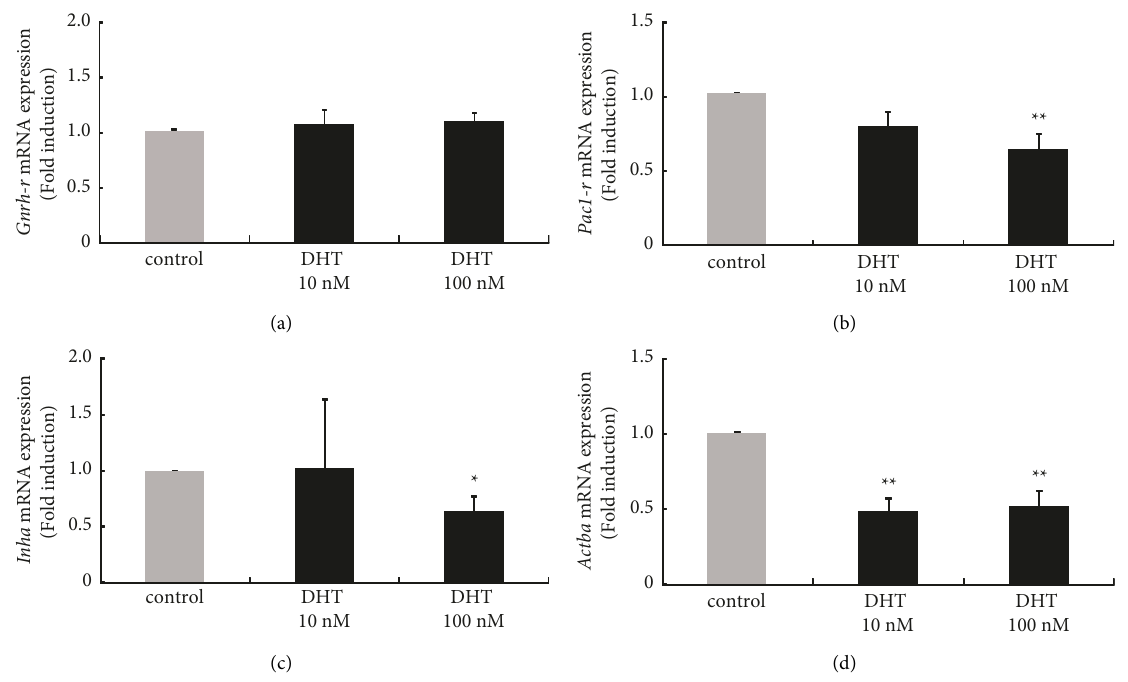
Figure 5: Effect of dihydrotestosterone (DHT) stimulation on the gene expression of GnRHR, PAC1R, and inhibin subunits in gonadotroph L β T2 cells. L β T2 cells were stimulated with the indicated concentrations of DHT for 24h After stimulation, mRNA was extracted and reverse transcribed, and mRNA levels of Gnrh-r (a), Pac1-r (b), and Inha (c) and Actba were measured by quantitative RT-PCR. Samples from each experimental group were run in duplicate and normalized to the mRNA levels of the housekeeping gene Gapdh. The results are expressed as fold induction over unstimulated cells and presented as the mean ± SEM of three independent experiments. ∗∗ P < 0 . 01, ∗ P < 0 . 05 versus control.